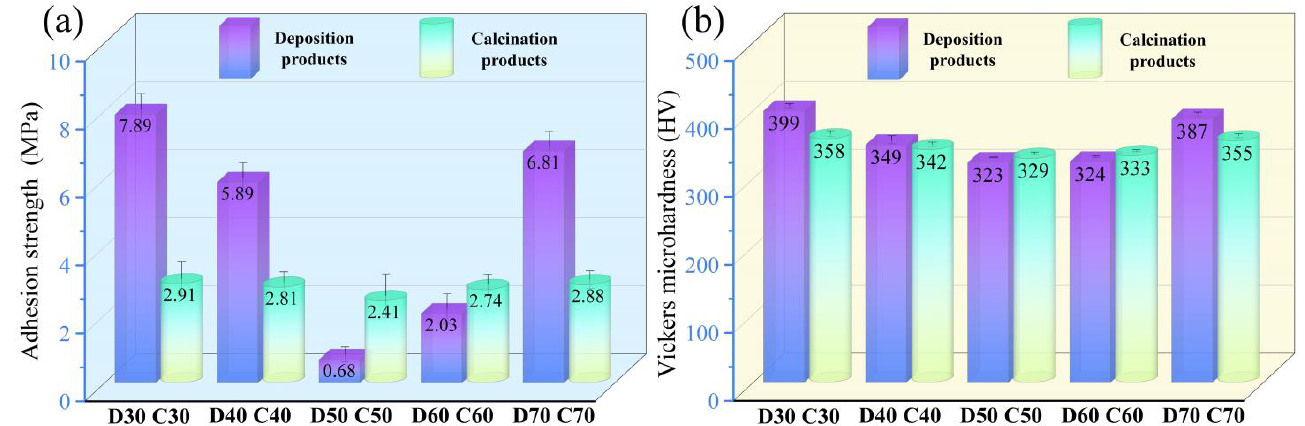
Figure 12. ( a ) Adhesion strength and ( b ) Vickers microhardness of the deposition products (D30–D70) and calcination products (C30–C70).